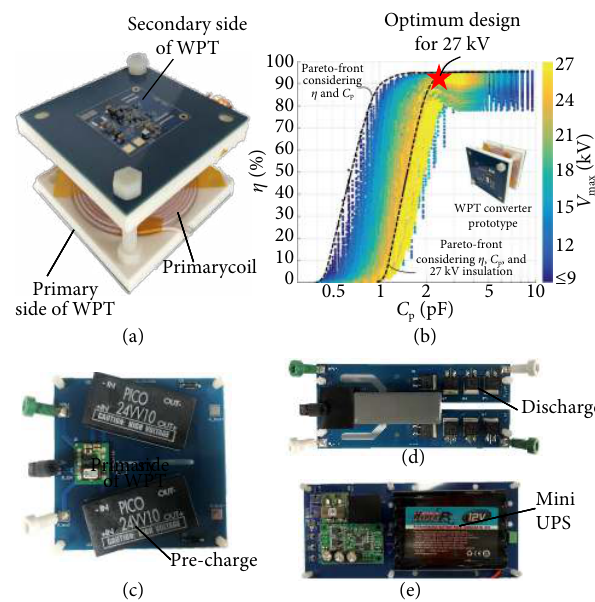
Fig. 4 (a) Hardware prototypes of the WPT. (b) Multiobjective optimization result of coils for WPT. The optimum design for 27 kV is marked with red star. (c) Hardware prototype of pre-charge. (d) Hardware prototype of discharge. (e) Hardware prototype of mini-UPS